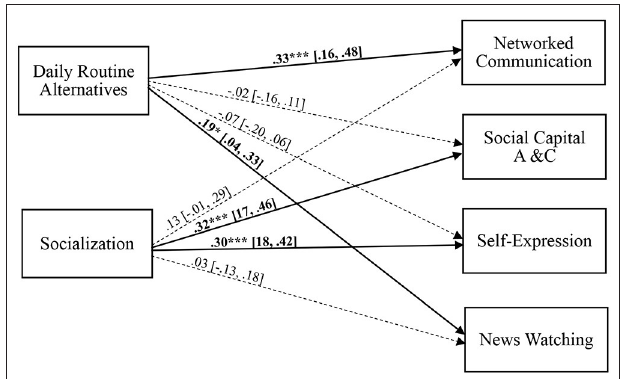
FIGURE 1 | The full model with standardized estimates. * p < 0.05. *** p < 0.001. The solid line represents significant effects. Ninety-five percent confidence intervals are reported within brackets. Model fit statistics: χ 2 = 0.16, df = 1, p = 0.69, CFI = 1.00, TLI = 1.09, RFI = 0.99, NFI = 1.00, RMSEA =